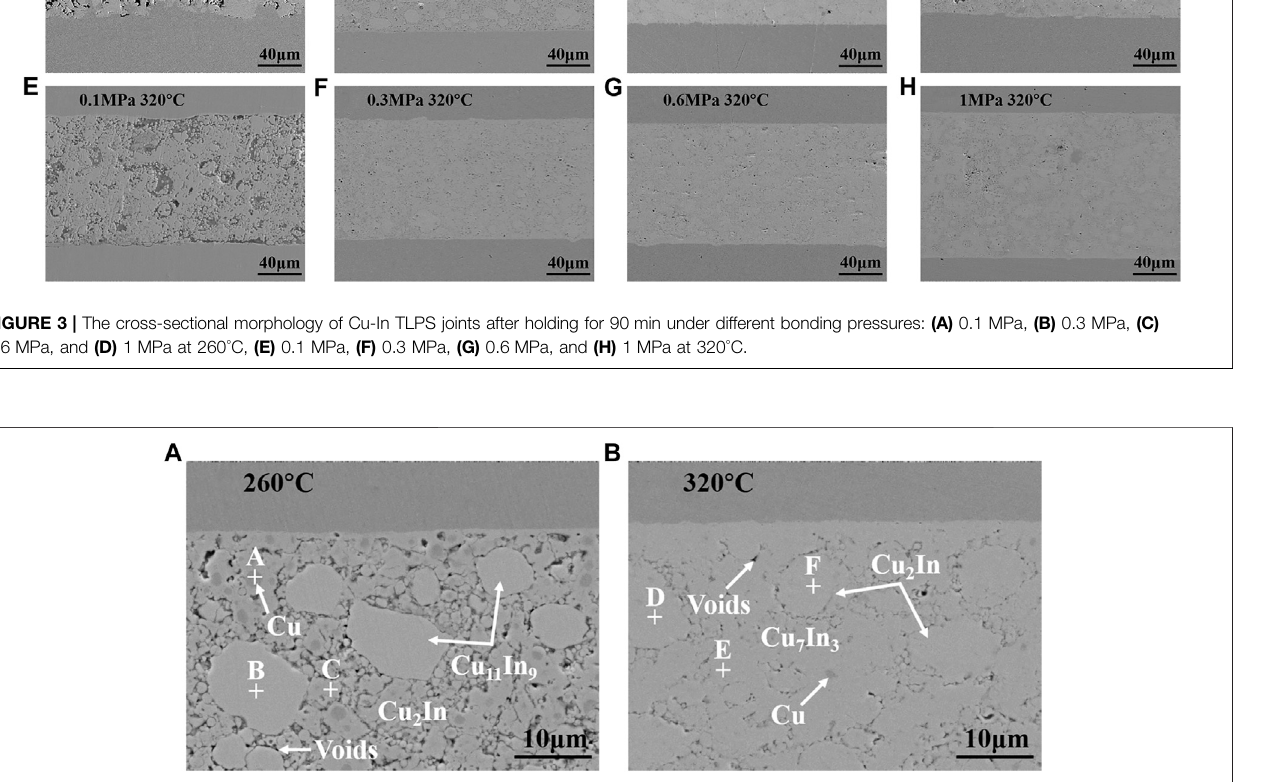
FIGURE4| Thepartiallyenlargedcross-sectionalmorphologyofCu-InTLPSjointsafterholdingfor90 minunderapressureof0.3 MPaat(A)260 ° Cand(B)320 ° C.